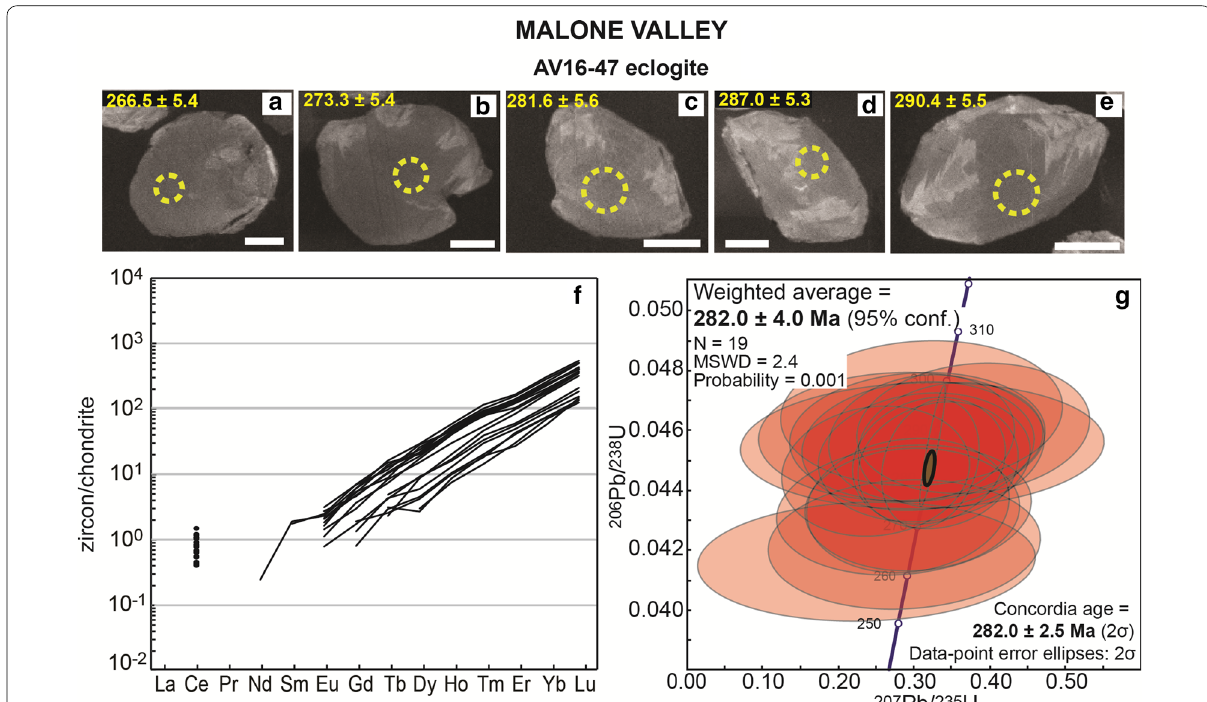
Fig. 6 Zircon in eclogite AV16-47 from Malone Valley. a – e Selected CC images of analysed zircon grains. Scale bar in all images is 30 μm. Measured spots are shown (yellow circles) with the associated date ( 1σ Ma). f REE patterns of zircons. Permian zircon crystals interpreted as magmatic have a ± steep REE pattern. g Concordia plot of zircon dates and weighted average 206 Pb/ 238 U age. The green circle represents the calculated Concordia